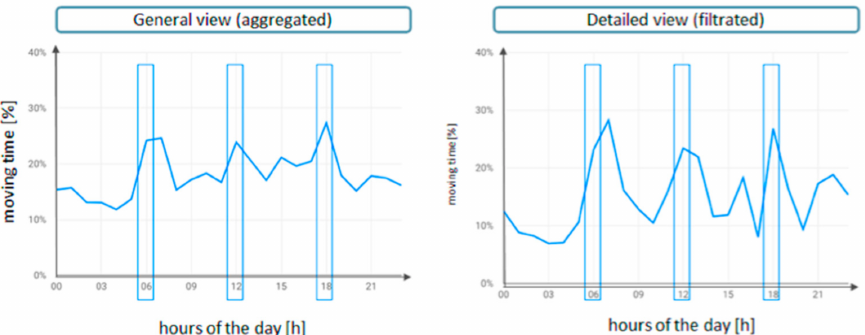
Figure 9. Averaging for all measured animals and twenty-four-hour units of motor activity of a given cow.